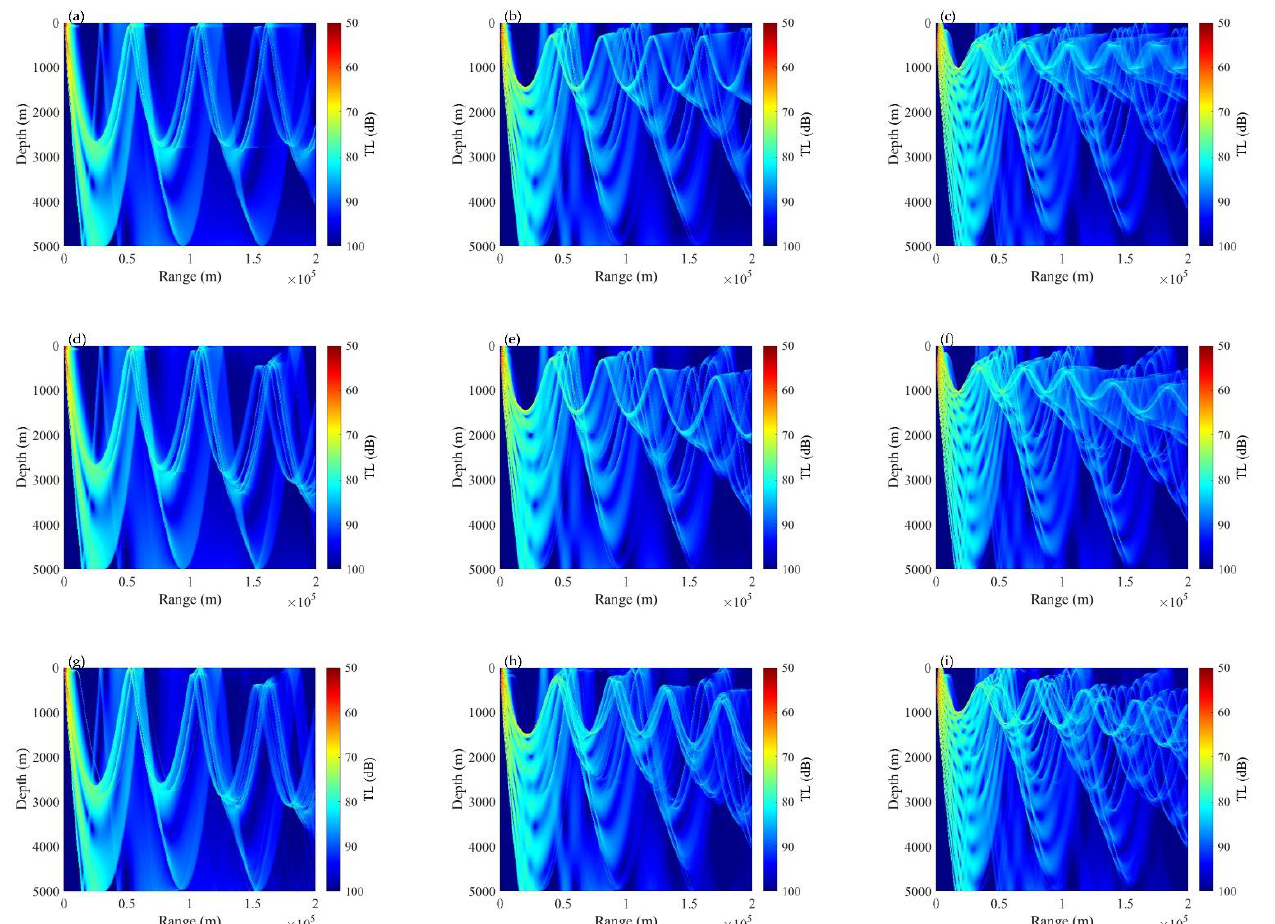
Figure 13. Comparison of TL between the distance-independent environment, model, and actual ocean front (1 January f = 50 Hz): the TL of distance-independent environment, and the SD = ( a ) 100 m, ( b ) 300 m, and ( c ) 500 m; the TL of the model, and the SD = ( d ) 100 m, ( e ) 300 m, and ( f ) 500 m; the TL of actual ocean front, and the SD = ( g ) 100 m, ( h ) 300 m, and ( i ) 500 m. Due to the existence of the ocean front, there was a significant downward shift in the distribution of TL after its passing through the frontal zone in the convergence area, which was a very obvious phenomenon is in both the model and the actual ocean front environments. The above phenomenon can help us achieve the forecasting of the depth change of the acoustic convergence area under ocean front environments.